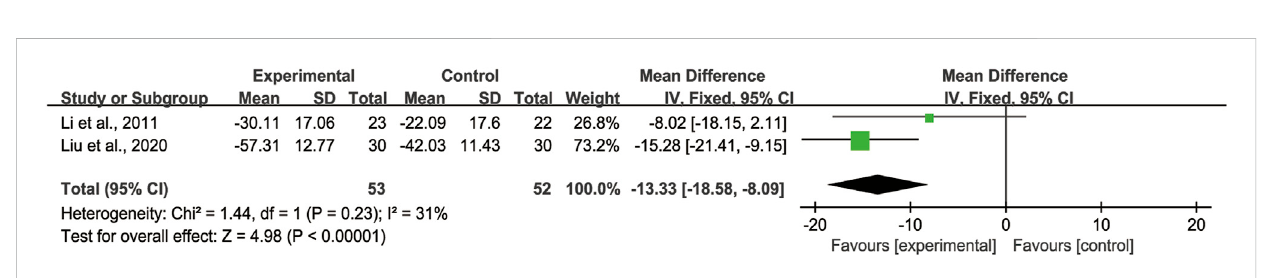
FIGURE 8 Forest plot of ESR: CHMs plus CTX treatment versus CTX